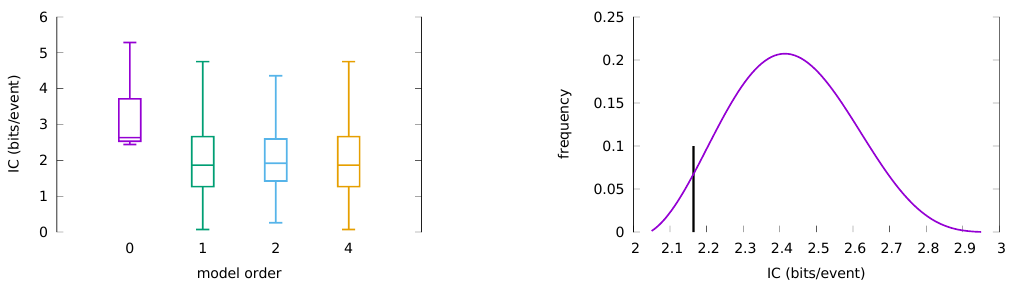
Figure 3. ( Left ): leave-one-out per event information content of the GRE corpus, under different orders of PPM( k ) model. ( Right ): the distribution of sequences generated by 10,000 iterations of random walk, for a template of 840 events and a PPM(2) model of the GRE corpus. The vertical black line marks the mean IC to the training